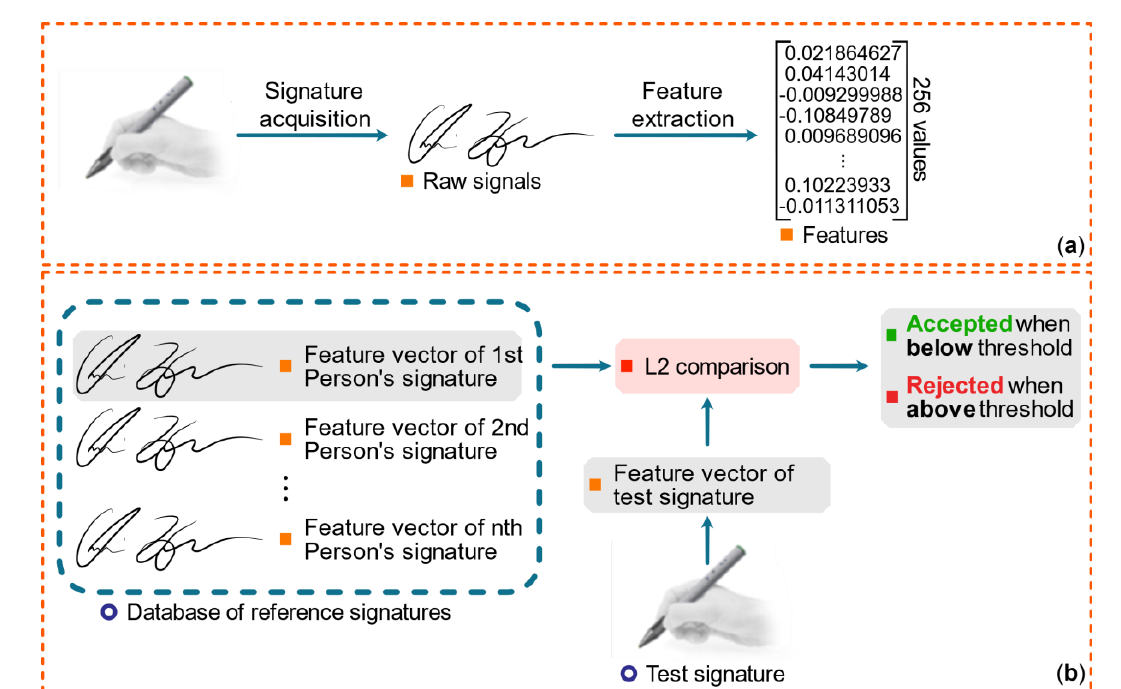
Figure 1. Diagram ( a ) shows the way each signature is processed to obtain its high-dimensional representation. Diagram ( b ) illustrates the verification process, where the signature provided by the client, the test signature, and the reference signature stored in the database are compared.